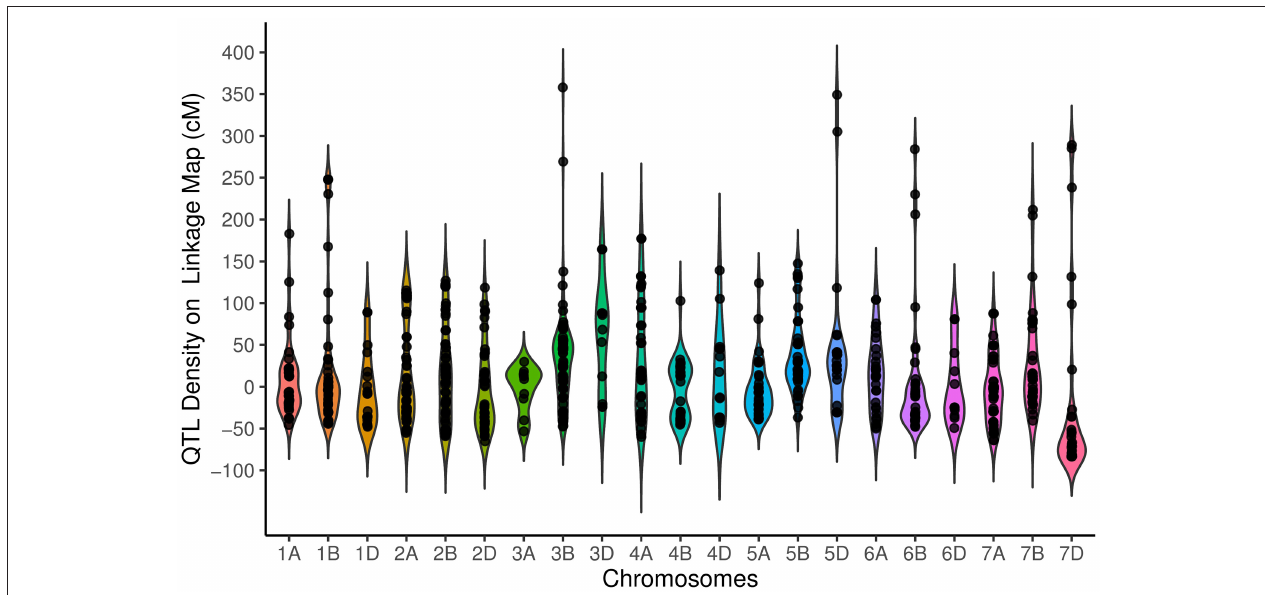
FIGURE 1 | Distribution of quantitative trait loci (QTLs) for traits on all chromosomes represented as the number of QTLs per distance (50cM), starting from the centromeric region of each chromosome where it was considered at the position 0cM. Each dot represents the exact location of each QTL.